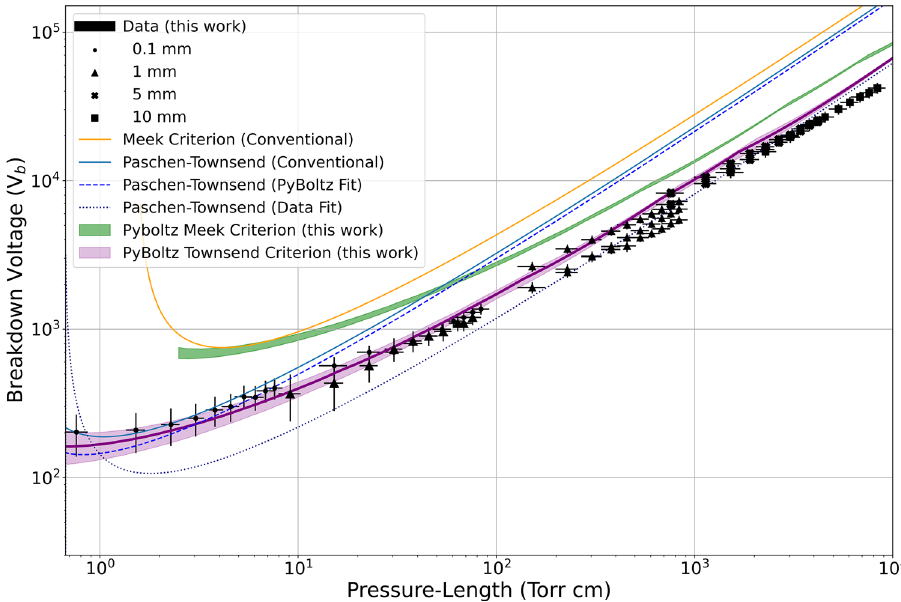
Fig. 4 Argon breakdown voltage vs. pressure-length data plotted alongside the theoretical